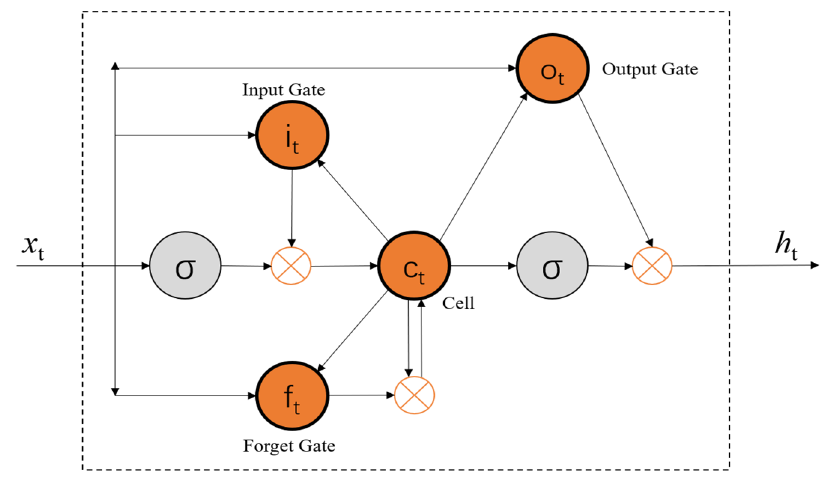
Figure 3. One-dimensional convolution feature extraction process diagram.